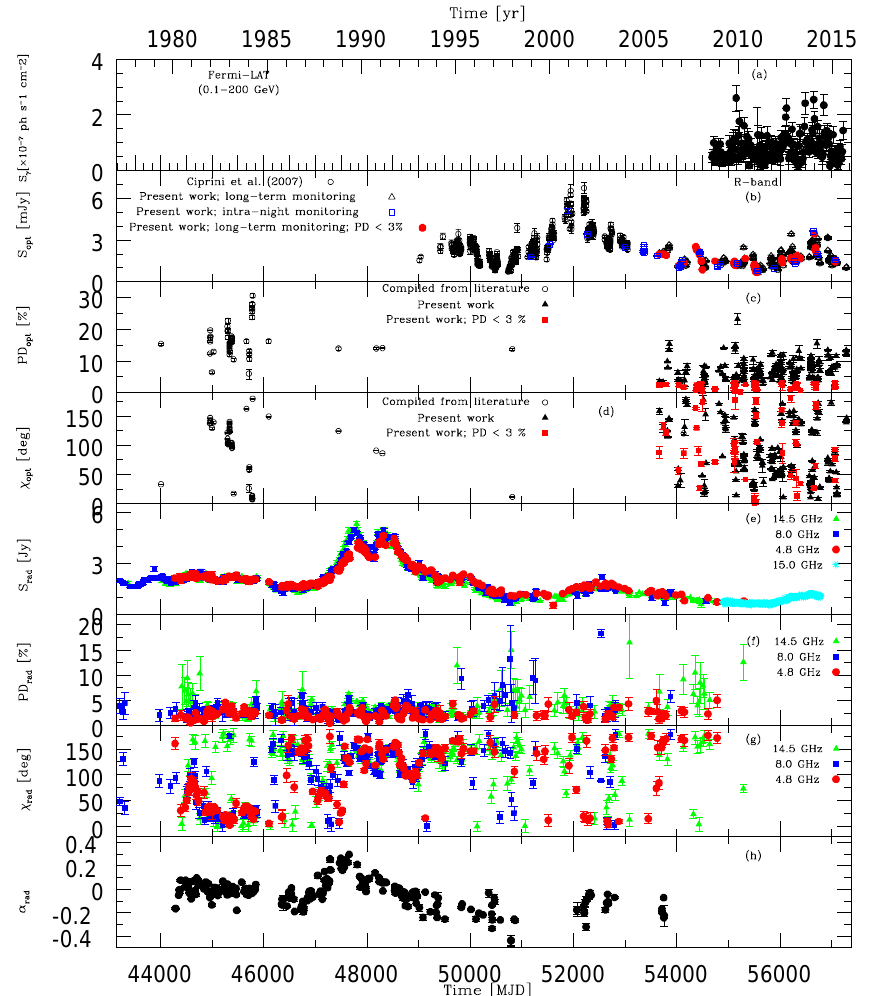
Figure 3. The long-term variability (LTV) lightcurve of BL Lac object PKS 0735 + 178. Panels a – d show the Fermi -LAT, R-band photometric flux, PD opt , and χ opt light curves, respectively; Panels d – f show the radio flux at different frequencies, PD rad , and χ rad , respectively; Panel h shows the run of radio spectral index (defined as S ν ∝ ν α ) calculated by a linear regression analysis of the flux values at the three frequencies (note that measurements at these frequencies were treated as simultaneous if they occurred within 14 days; i.e., q = 0.04